Question: Express in one sentence what the figure is showing.
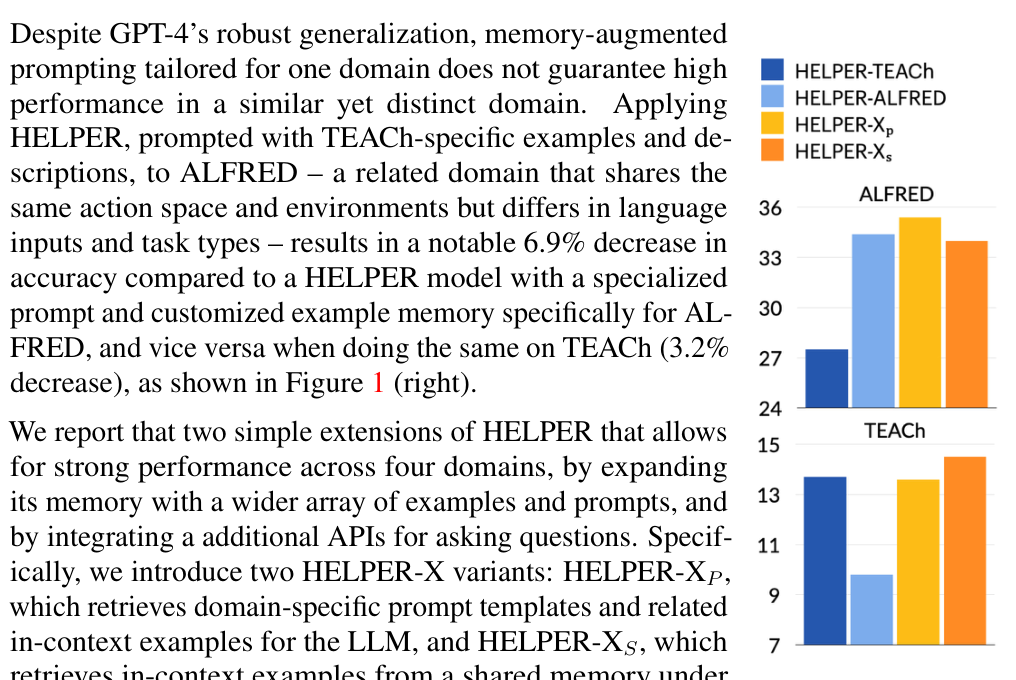
Answer: TEACh-tailored HELPER Sarch (2023) demonstrates a 6.9% drop in success when applied to ALFRED, despite sharing the same action space and environments, due to vari- ations in language inputs and tasks. HELPER-X consistently performs well in both domains with one model.